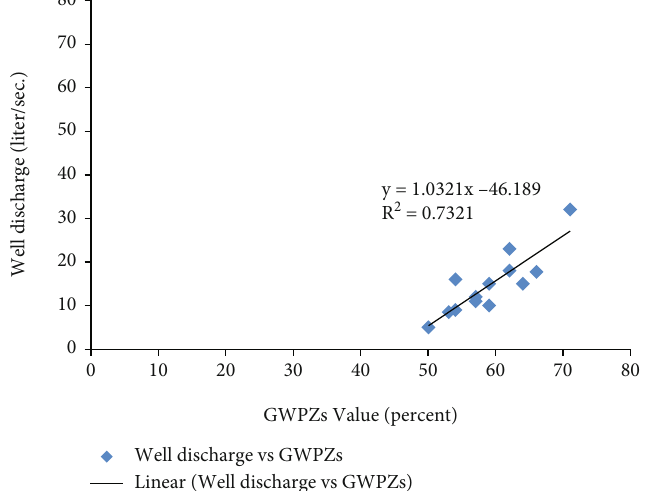
Figure 17: Correlation between GWPZs and well